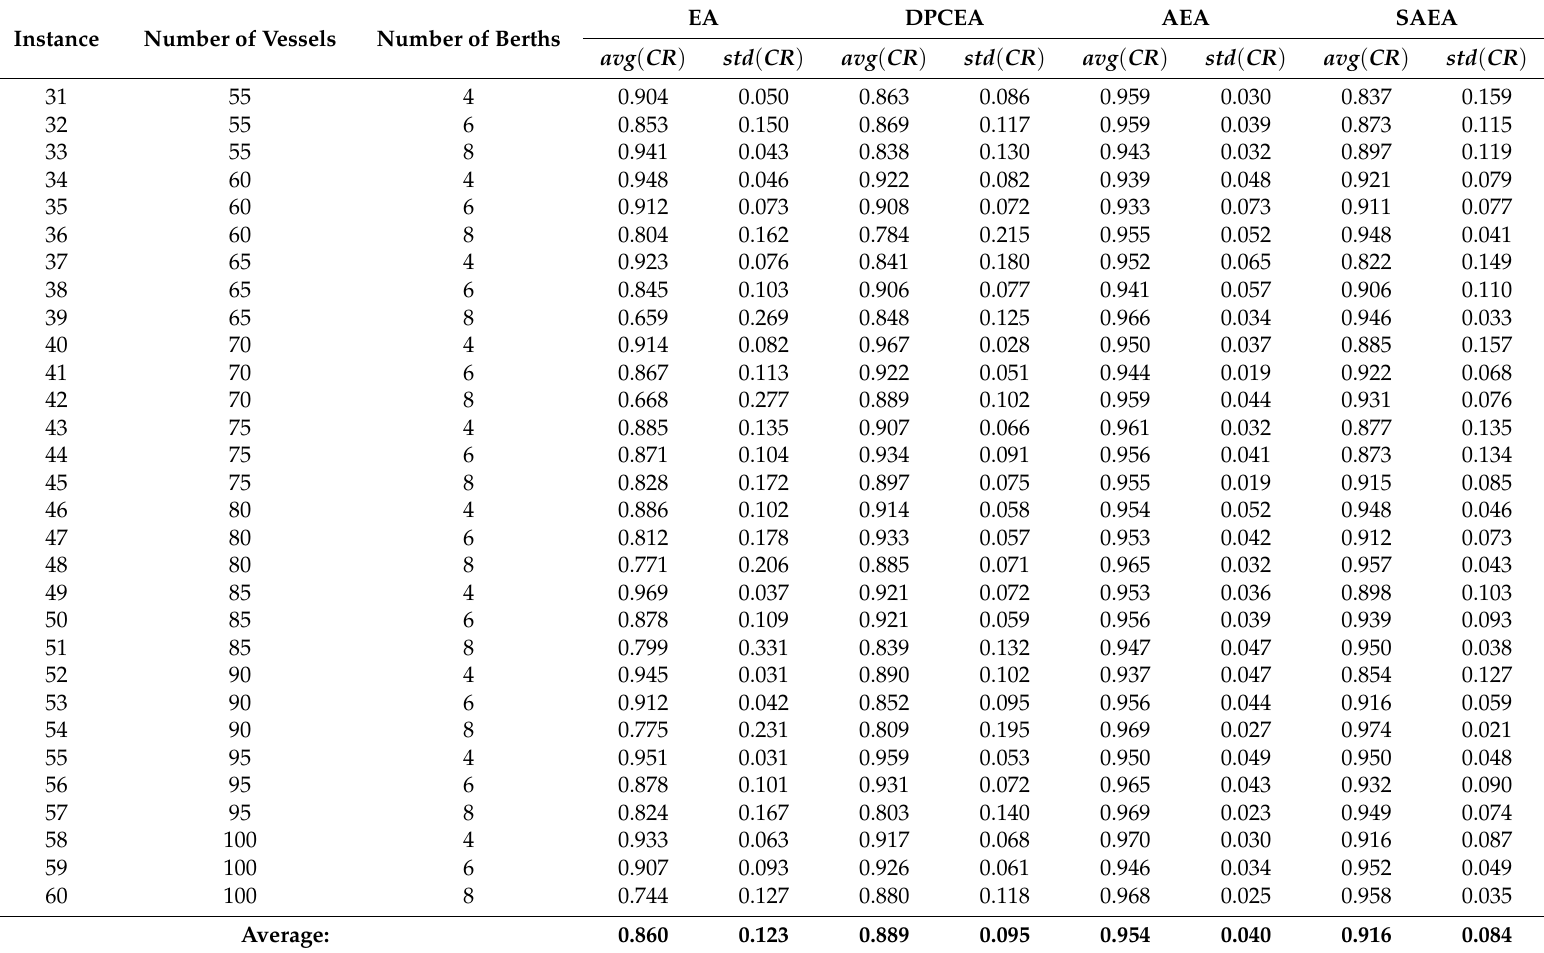
Table 7. The convergence rate values for the developed solution algorithms and large size problem